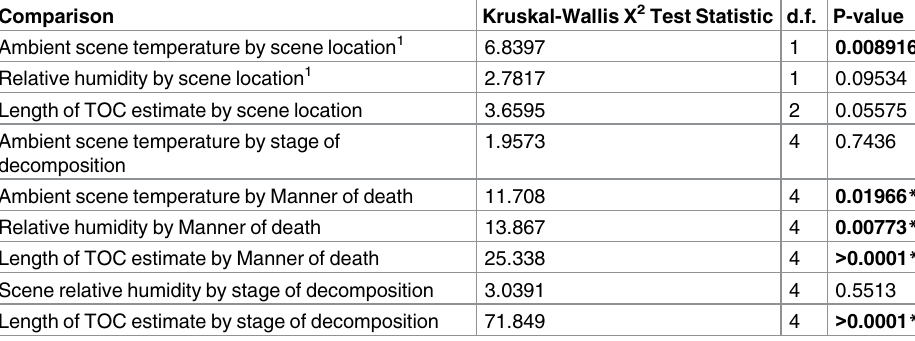
Table 3. Kruskal-Wallis chi-squared test results.